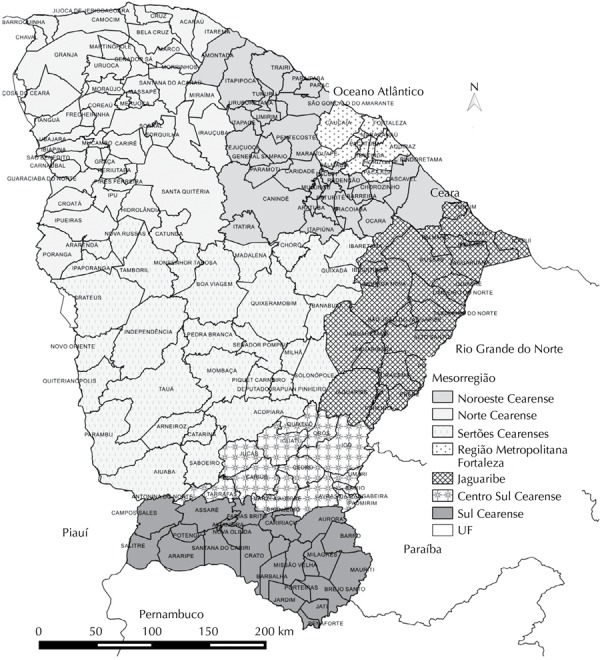
Mapa dos municípios e mesorregiões do estado do Ceará segundo censo demográfico de 2010. Brasil, 2014.